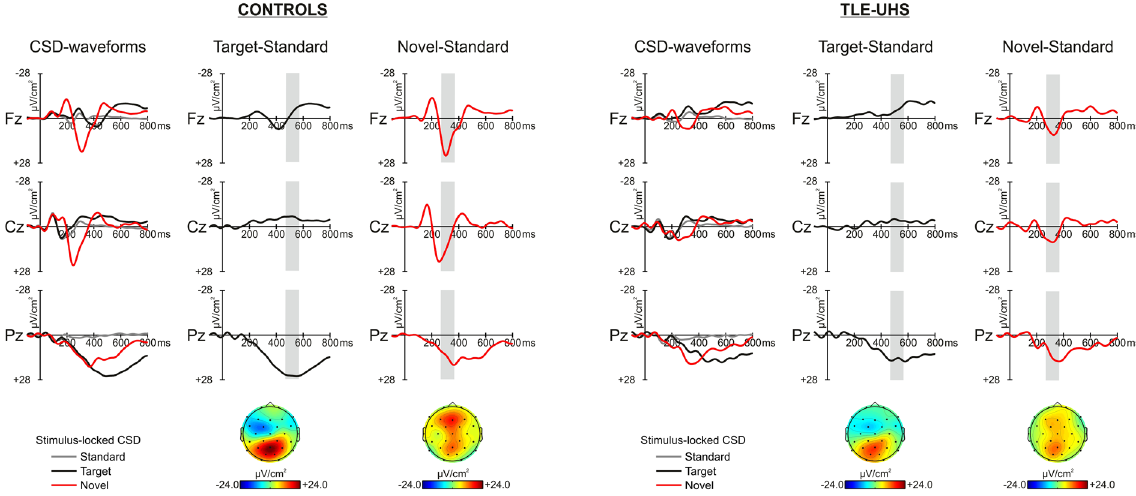
Figure 2. Grand mean CSD waveforms for standard (grey line), target (black line) and novel (red line), at midline electrodes (Fz, Cz, and Pz), from –100 to 800 ms, for both the control and the TLE-UHS group. Grey areas indicate the time-windows considered for the analyses. Difference waveforms associated to the target minus standard (black line) and novel minus standard (red line) are showed. Bottom part: scalp distribution of the P3b source (Target minus standard, − 24/24 μ V/cm 2 ), and of the P3a source (Novel minus standard, − 24/24 μ V/cm 2